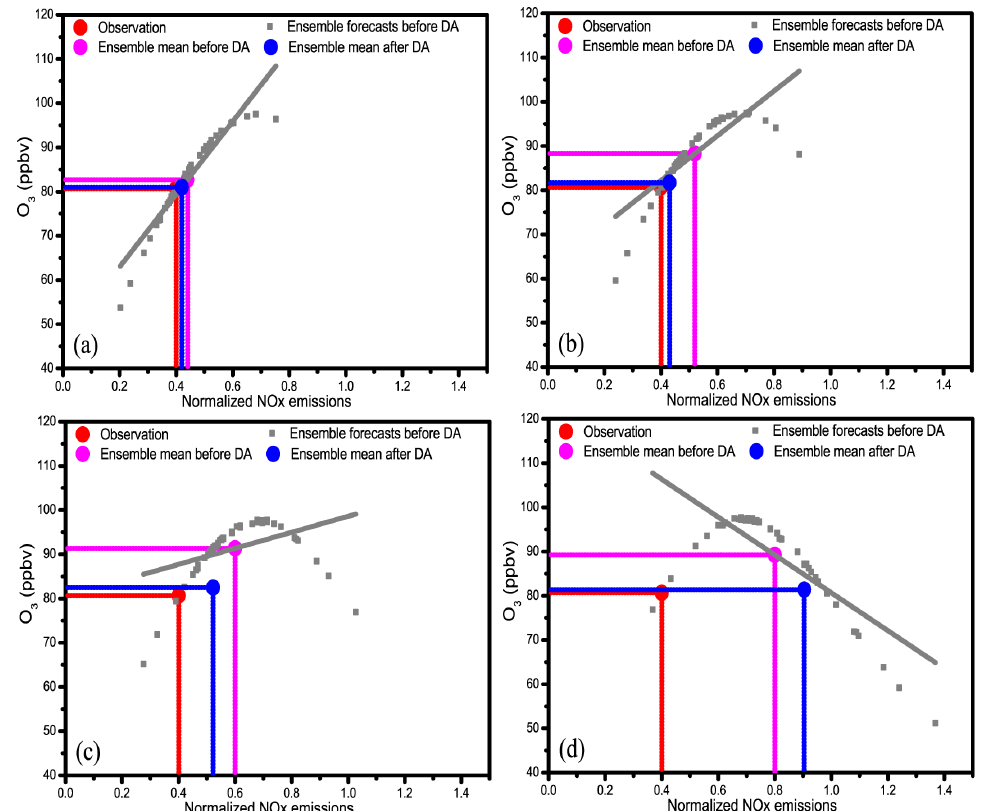
Figure 5. (a–d) O 3 concentrations (ppbv) and NO x emissions (no unit, normalized by the true NO x emission) before and after data assimi- lation and their ensemble samples before DA at 12:00LT on 12 August 2008 in the four idealized DA experiments. (a) DA experiment with 10% overestimate in the a priori NO x emission; (b) DA experiment with 30% overestimate in the a priori NO x emission; (c) DA experiment with 50% overestimate in the a priori NO x emission; (d) DA experiment with 100% overestimate in the a priori NO x emission. The magenta dot, the gray squares, the gray line, the red dot, and the blue dot represent the same information as in Fig. 4.